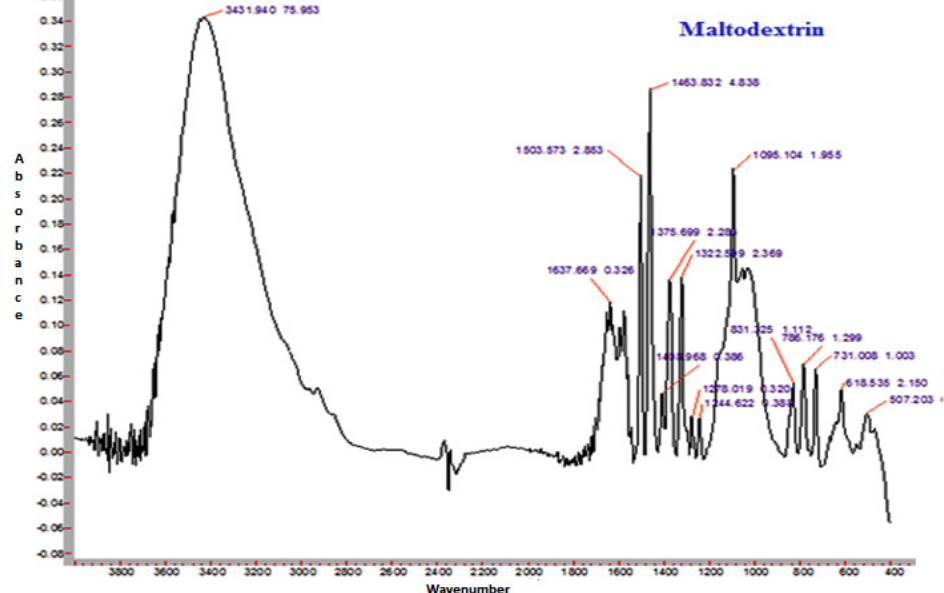
Figure 4. Representative FTIR spectrum of spray-dried nutritionally rich honey powder fortified with maltodextrin